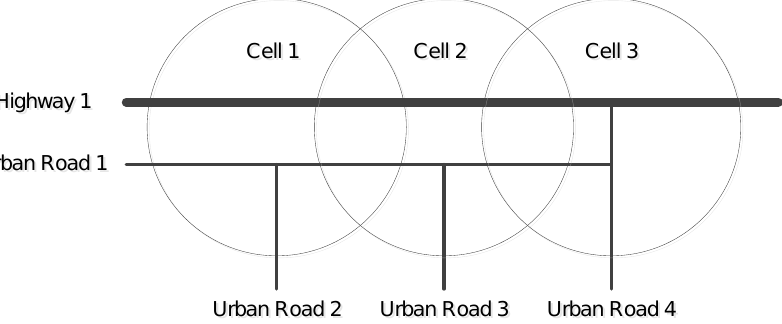
Figure 1. The case study of CFVD for highway and urban roads.